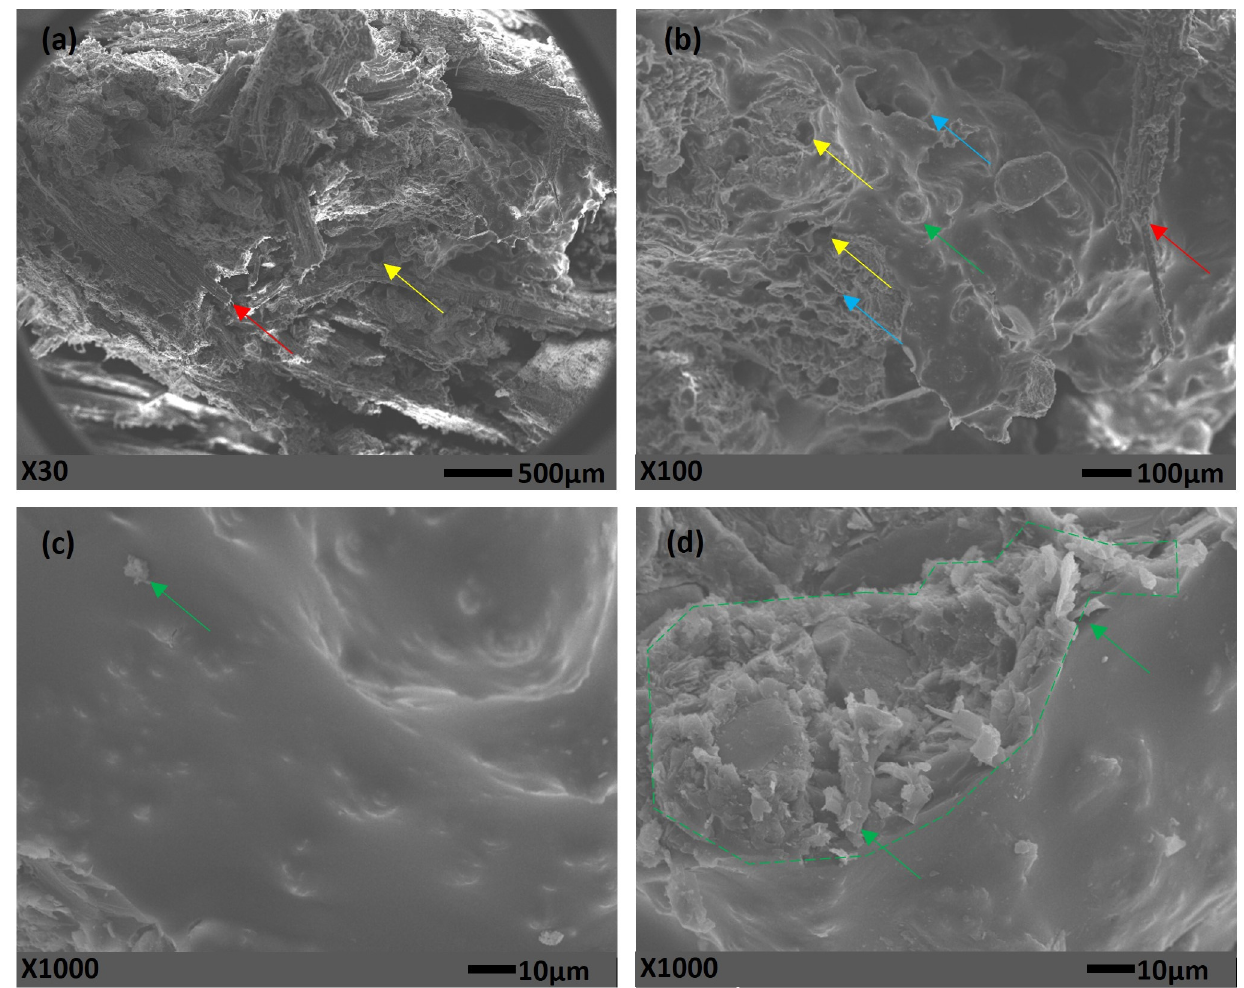
Figure 8. SEM composites manufactured by hot pressing, with chamotte.